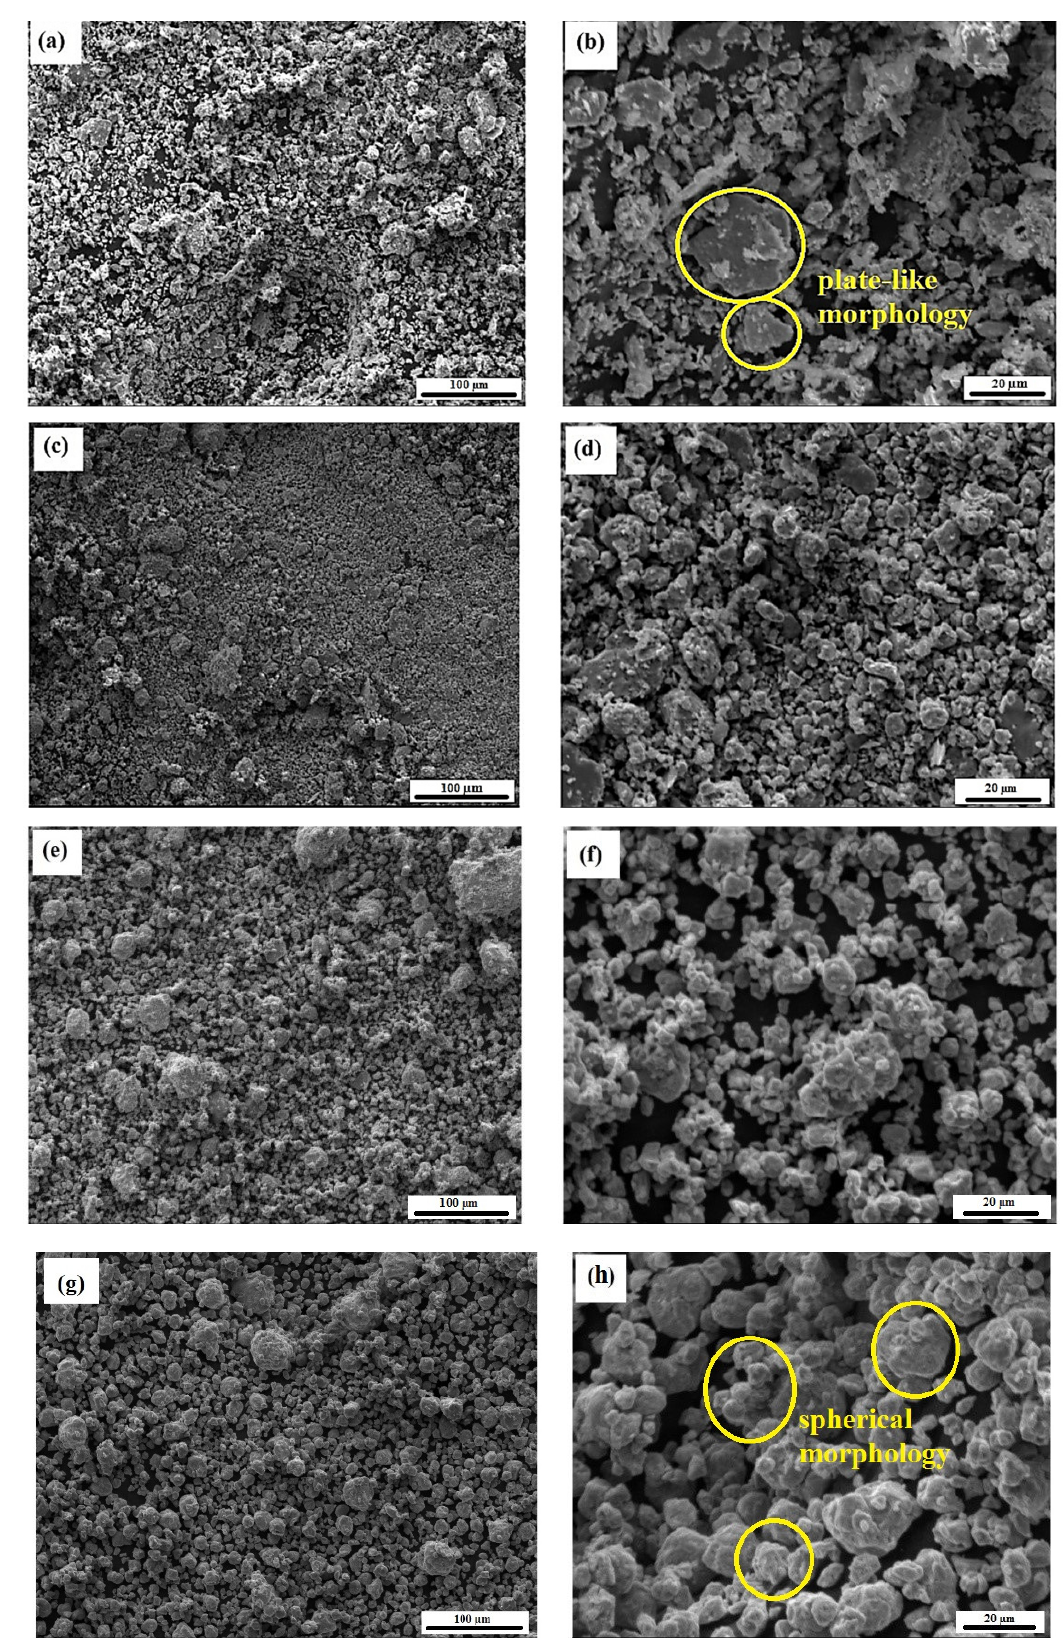
Figure 6. SEM images of the AlCrCuFeNi HEA after ( a , b ) 10 h, ( c , d ) 30 h, ( e , f ) 50 h, and ( g , h ) 60 h of milling. Figure 7 shows the EDS-point analysis of the 60-h-milled powder samples. The atomic percentage and chemical composition of the elements in this sample are close to that of the initial powder. A slight separation of Fe and Cr from the balls and vial might be the cause of the minor increase in their weight percent. Moreover, the presence of oxy- gen is attributed to the partial oxidation of the powder particles; however, due to the low amount of oxidation, no oxide phase was detected in the XRD test (Figure 1). The sources of oxygen during MA can be the decomposition of the stearic acid and imperfectly pro- tected atmosphere, before the process and/or after the process, during the tests. The oxy- gen entered into the system reacts with the surface of the particle powders, especially Al, which can easily react with oxygen. ( a ) ( b ) Figure 7. The EDS spectrum ( a ) and quantitative analysis ( b ) of AlCrCuFeNi alloy after 60 h of milling. 3.4. Thermal Behavior of the Alloy Thermal stability of the AlCrCuFeNi alloy was analyzed using DSC analysis and dif- ferent annealing heat treatments. Figure 8 illustrates the DSC curve for the 60-h-milled AlCrCuFeNi HEA (with 2 wt. % of PCA) heated from room temperature to 1200 °C at a heating rate of 10 °C/min. In the DSC curves, one endothermic peak at 72 °C and two exothermic peaks at 572 and 706 °C can be seen. The first endothermic peak at about 72 °C can be related to the energy absorption of the residual PCA evaporation. The long ex- othermic line from 100 to 520 °C indicates the release of internal stresses introduced by lattice strain and structural deformation [30], and the two exothermic peaks may be re- lated to the energy released during phase transformations.